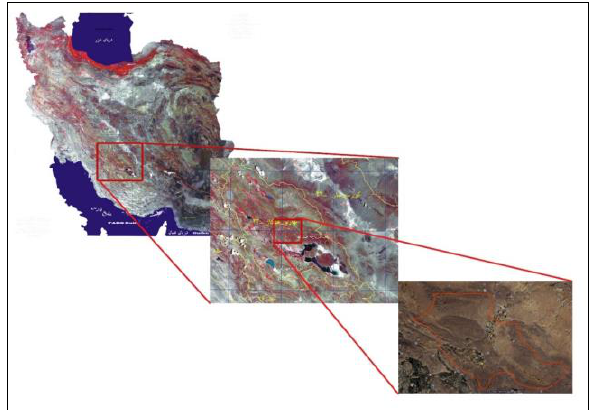
Fig 1- The location of Case study